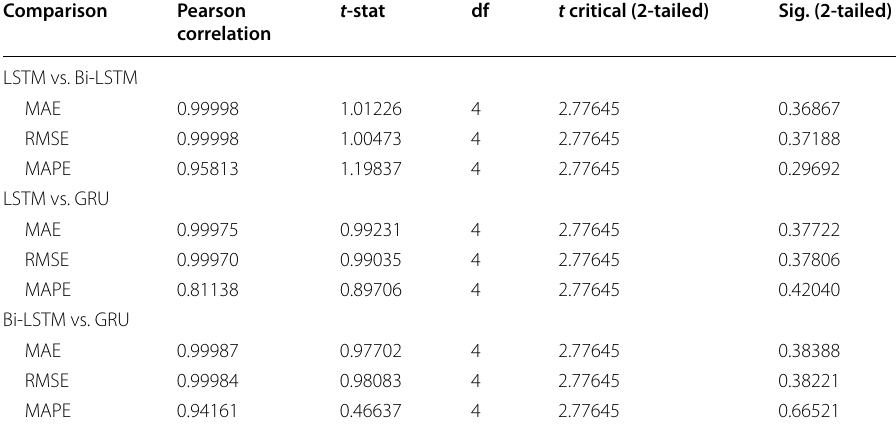
Table 3 t -test results